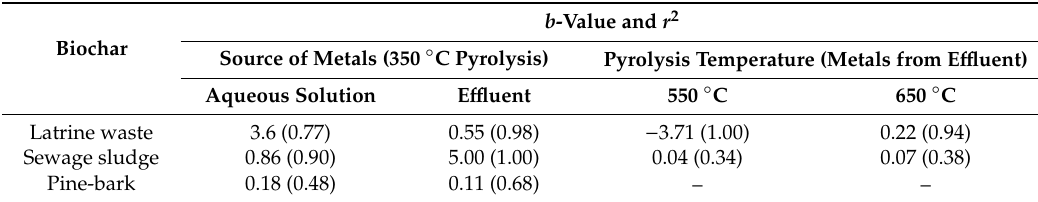
Figure 2. Maximum zinc sorption on faecal and pine-bark biochar pyrolysed at 350 ◦ C ( a ) and on faecal biochar at increasing pyrolysis temperatures ( b ). Table 1. The b (L kg − 1 ) and r 2 values of linearized Langmuir models of zinc on biochars from latrine waste, sewage sludge and pine